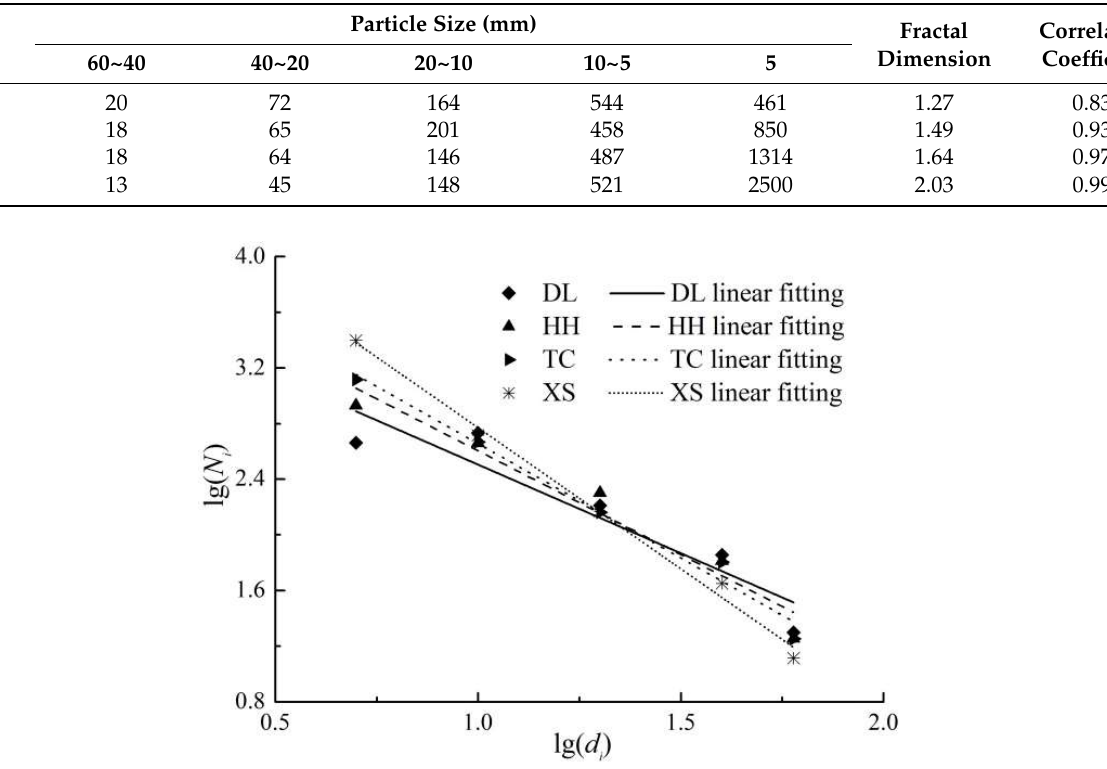
Figure 2. Linear fitting between lg( d i ) and lg( N i